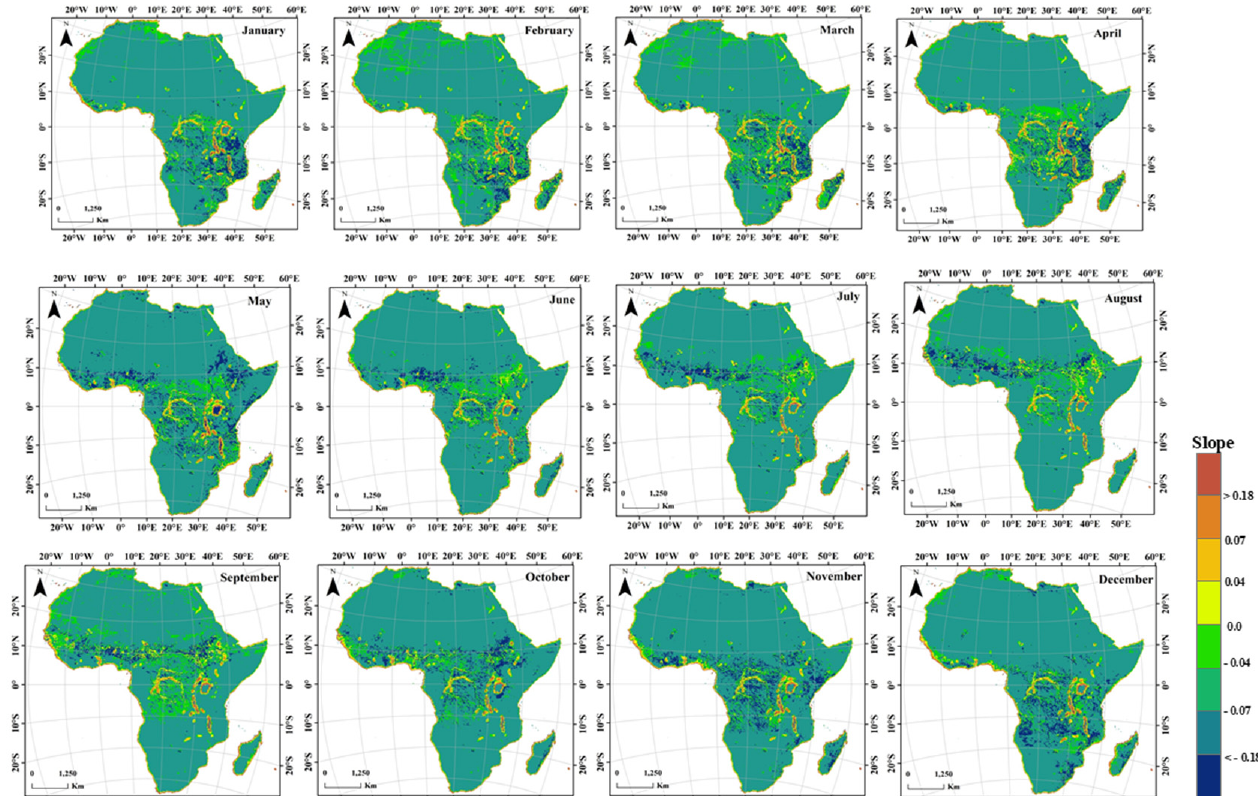
Figure 9. The interannual change (slope) of the monthly average soil moisture from 2003 to 2017.